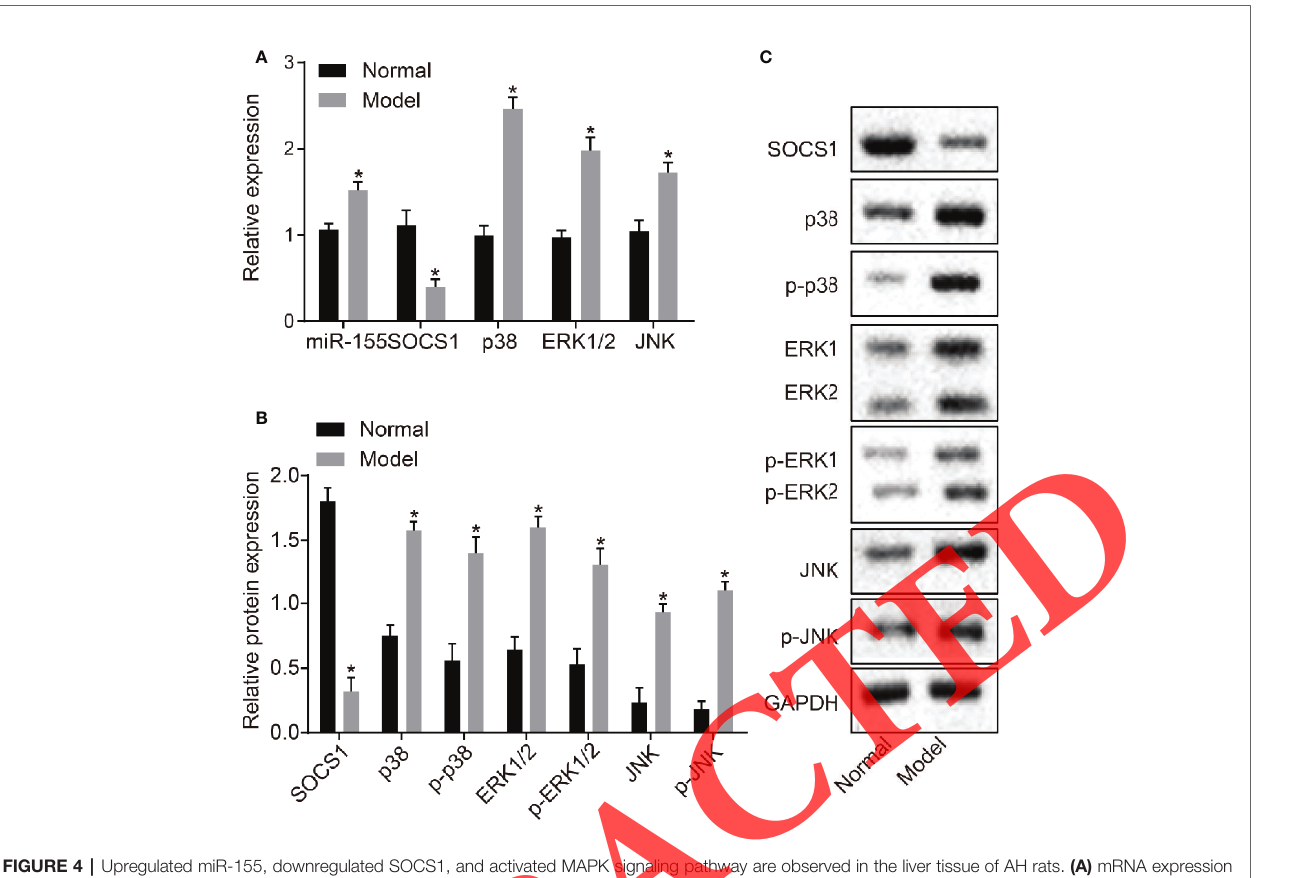
FIGURE 4 | Upregulated miR-155, downregulated SOCS1, and activated MAPK signaling pathway are observed in the liver tissue of AH rats. (A) mRNA expression of miR-155, SOCS1, p38, ERK1/2, and JNK in rat liver tissues. (B, C) Protein expression of SOCS1, p38, ERK1/2, and JNK in rat liver tissue. * p < 0.05 AH vs . normal hepatic stellate cells. The measurement data are expressed as mean ± standard deviation and compared by an unpaired t -test (n = 8). SOCS1, suppressor of cytokine signaling 1; MAPK, mitogen-activated protein kinase; AH, alcoholic hepatitis; RNA, ribonucleic acid; ERK, extracellular regulated protein kinases; JNK, Jun N-terminal